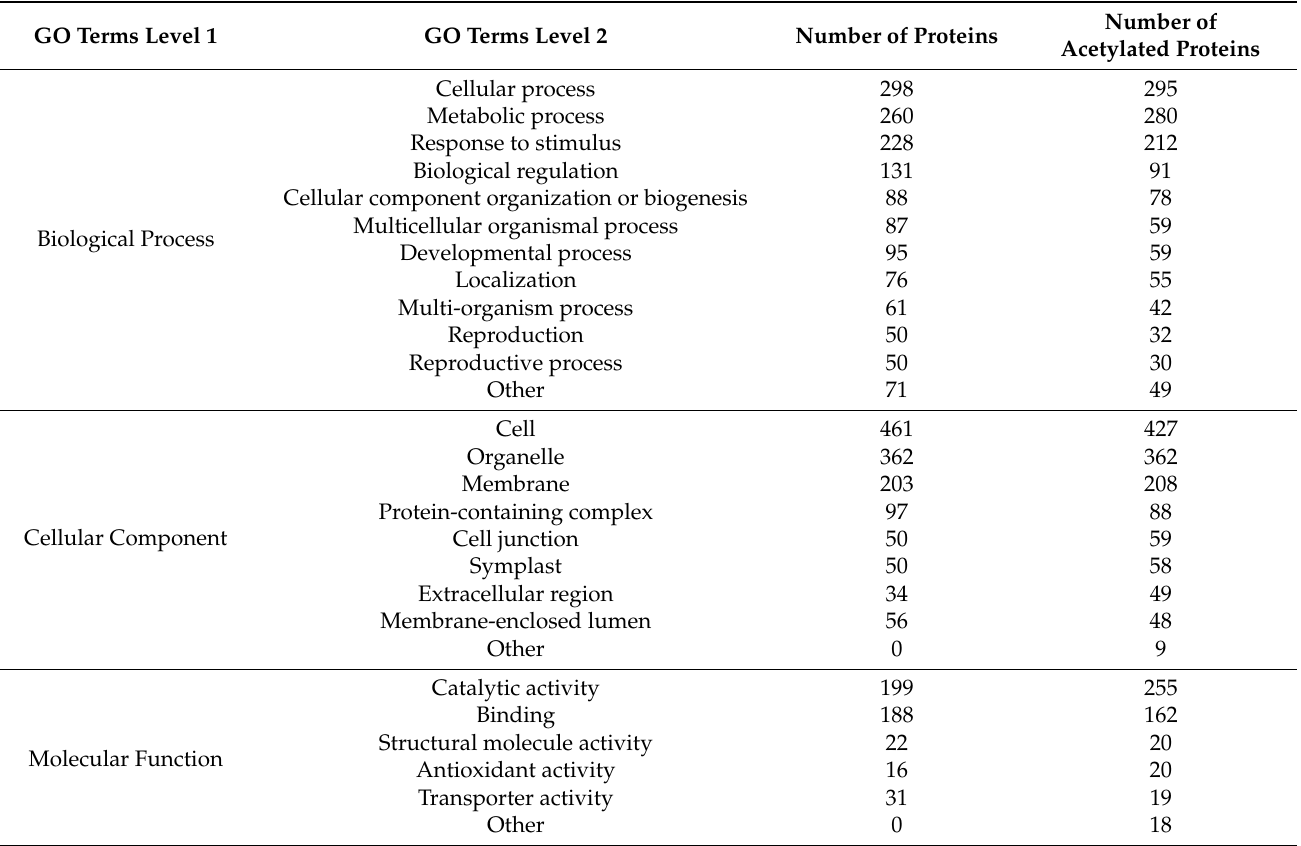
Table 1. GO classification number of differential acetylated protein and differential expressed protein under UV-B